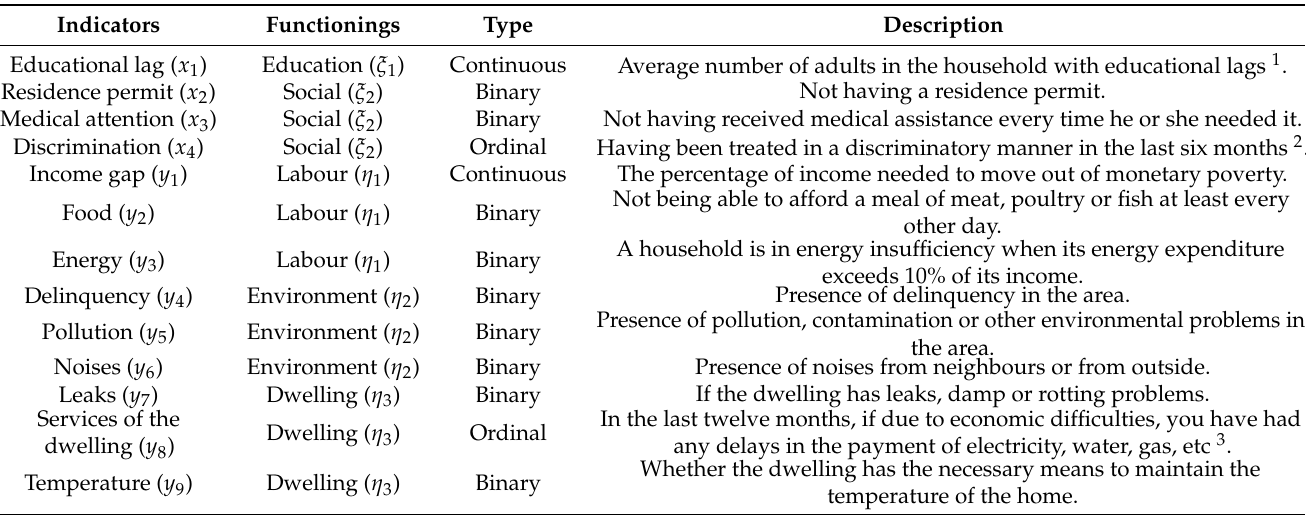
Table 1. Latent variables and measurement